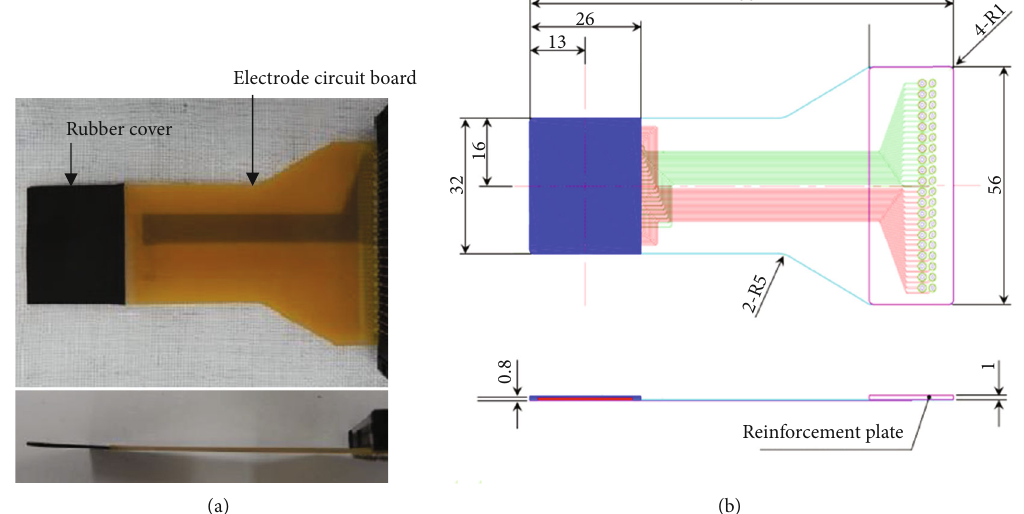
Figure 1: Novel pressure-sensitive conductive rubber sensor: (a) plane and side view and (b) design drawing (unit: mm).